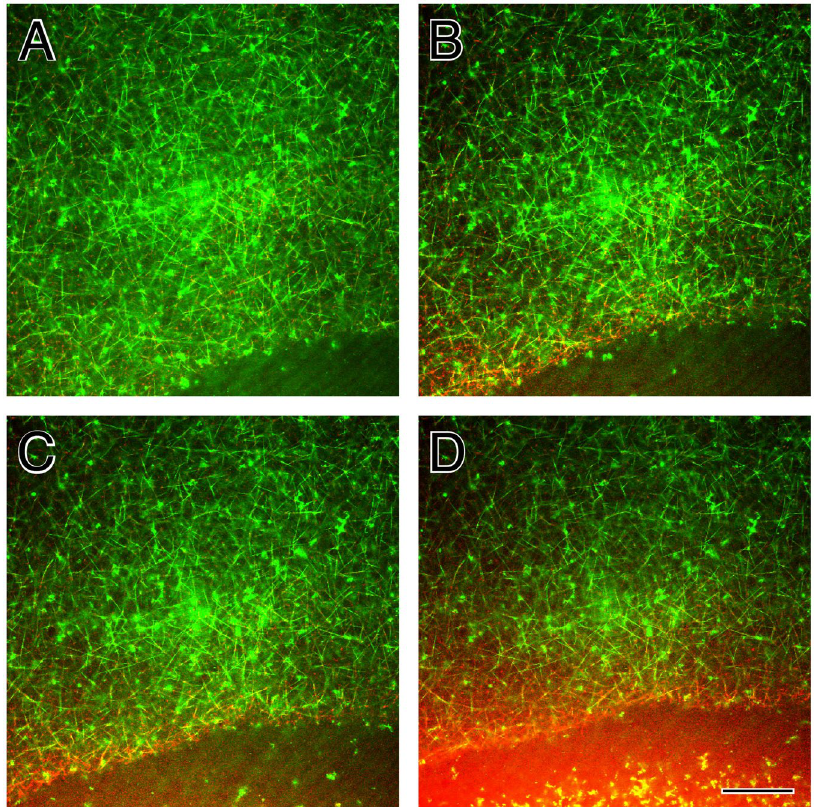
Figure 3. Confocal micrographs of a fibrin clot during fibrinolysis initiated by tPA. Fluorescently labeled fibrin is green, tPA is red, and the overlap of fibrin and tPA thus makes yellow. Micrographs are ( A ) initial image, ( B )